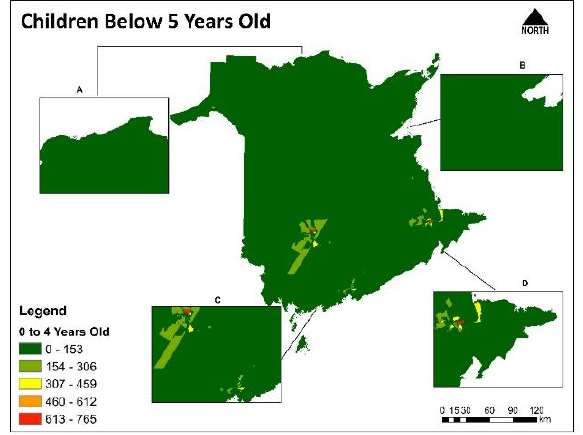
Figure A11. Children Below 5 Years Old.